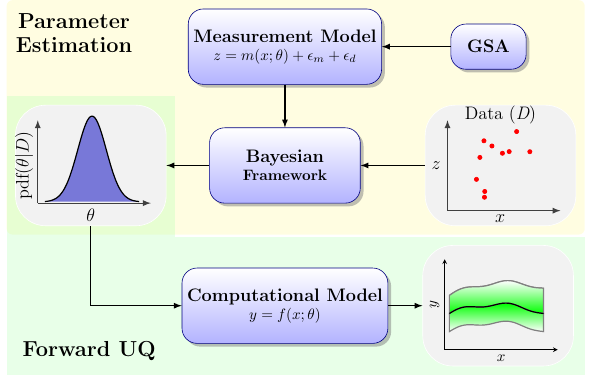
Figure 1. Schematic of parameter estimation, on yellow back- ground, and forward UQ workflows, on green background. For this work DALEC is used as both “measurement model”, m , and as “computational model”, f . In the Bayesian framework, parameter estimation depends both on the model error (cid:15) m and on the measure- ment error (cid:15) d